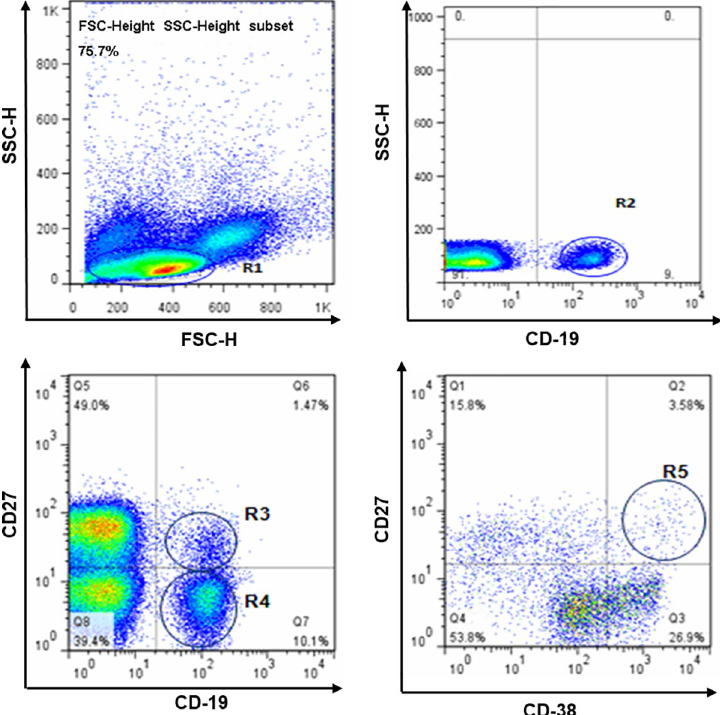
Fig 1. Analysis of B cells and plasma B cells. B cell and B cell subset PBMCs stained with CD19–APC, CD27-FITC, and CD38-PE gated on lymphocyte (R1), total B cells (R2, CD19+), na ï ve B cells (R3, CD19+CD27-), memory B cells (R4, CD19+CD27+), and then plasma B cells (R5,